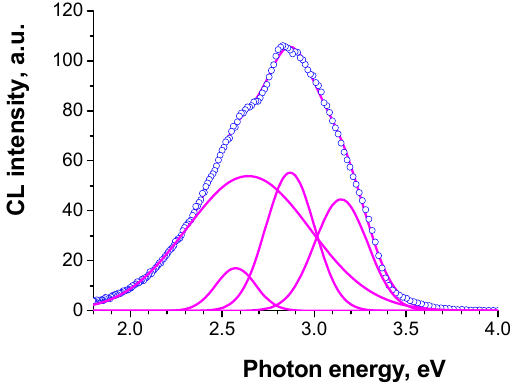
Figure 19. Typical CL spectrum measured on the flat surface of sample S6 with a beam energy of 10 keV (blue symbols). The emission bands and the resultant simulated spectrum are shown with magenta lines.